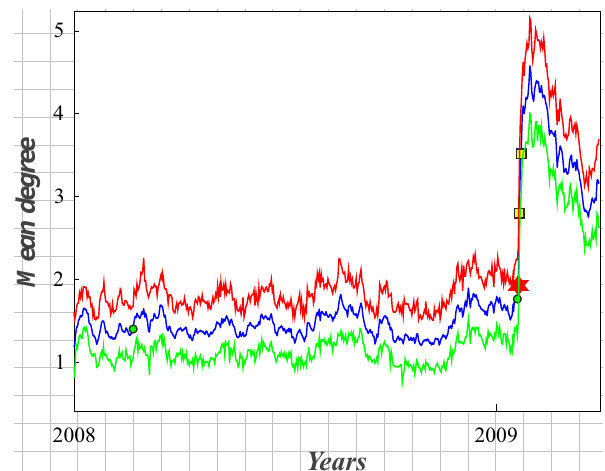
Figure 7. The mean degree of the seismic network (blue line) as computed using sliding windows with the constant time shift of 1 day. Red and green lines represent statistically significant levels of 95 and 5%, respectively, as obtained from an ensemble of equiv- alent random networks (see the description in the methods